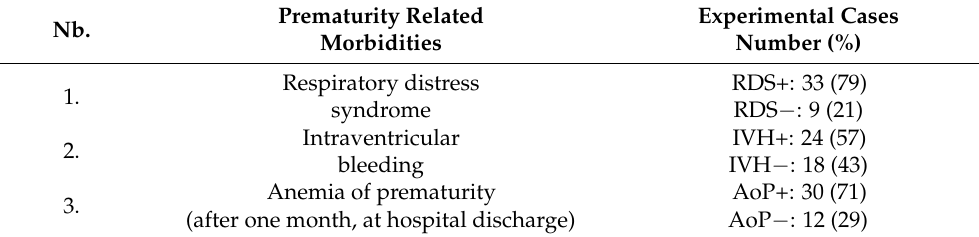
Table 2. Frequencies of clinicopathological aspects in preterm newborn